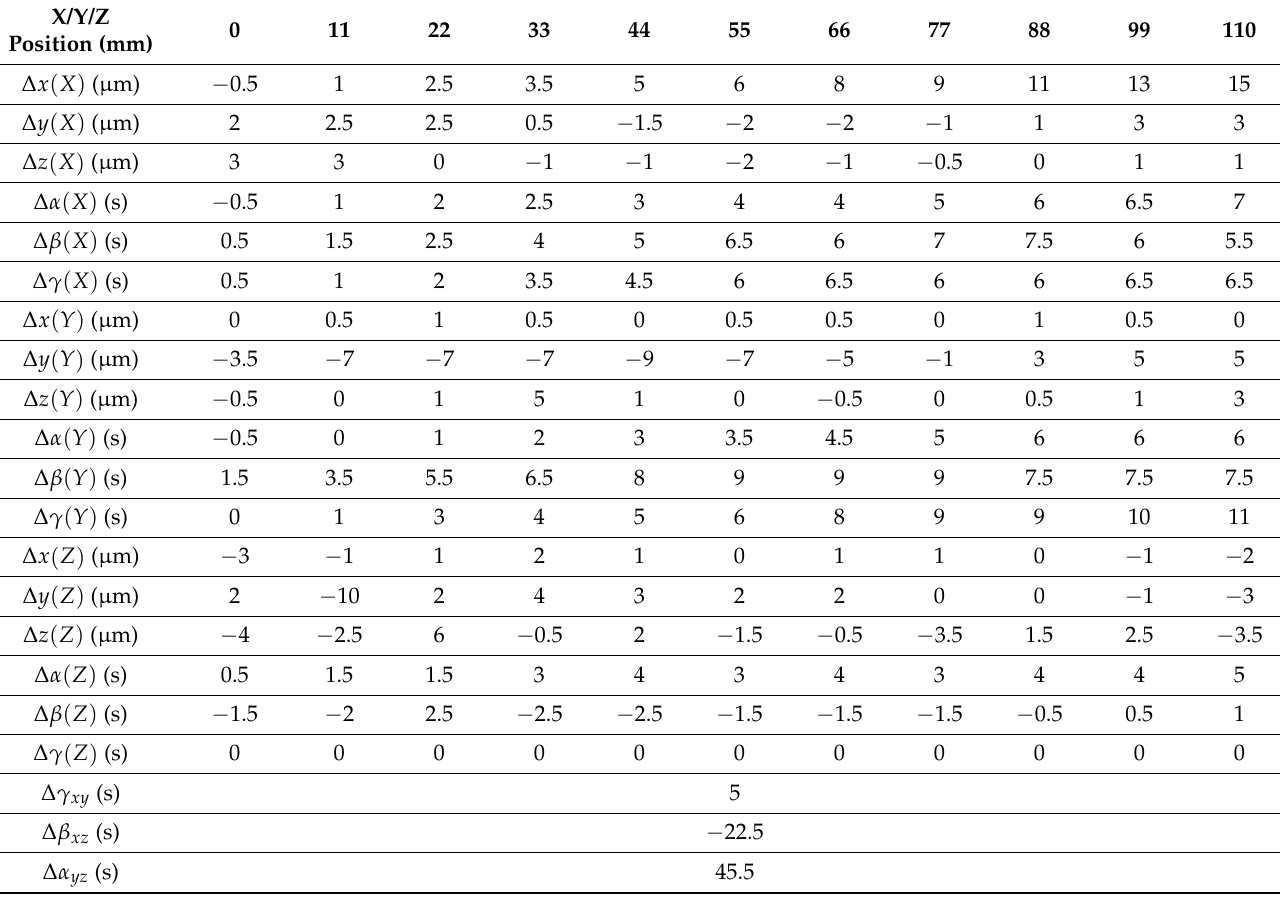
Table 6. Measured 21 geometric